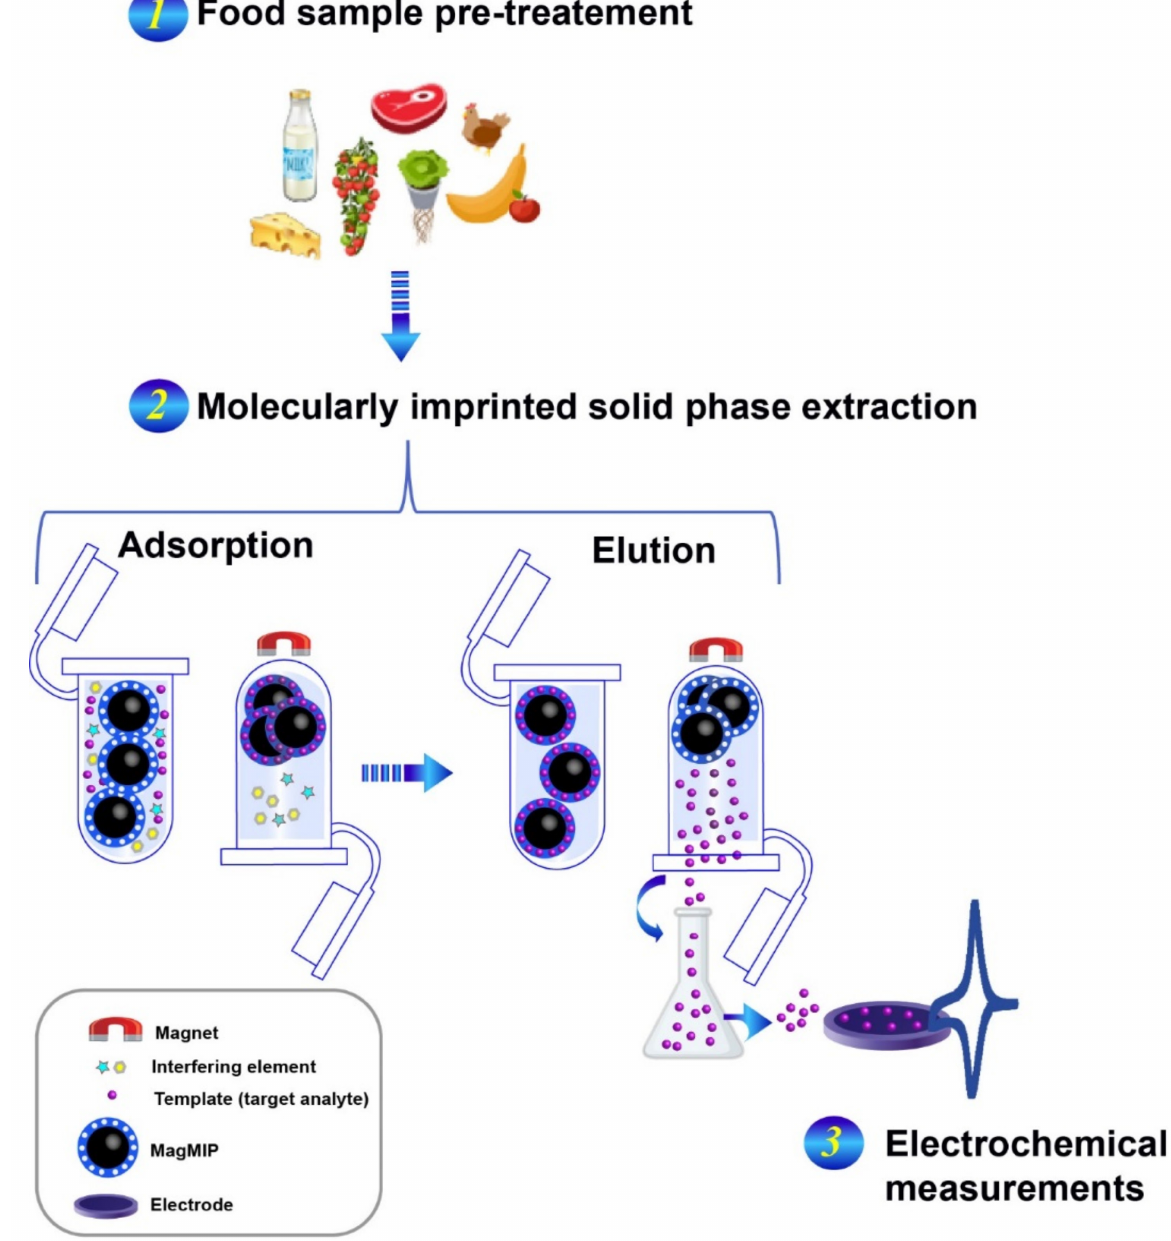
Figure 6. Schematic procedure for the electrochemical sensing of the target analyte coupled magnetic-MIP as solid-phase extraction from a complex food